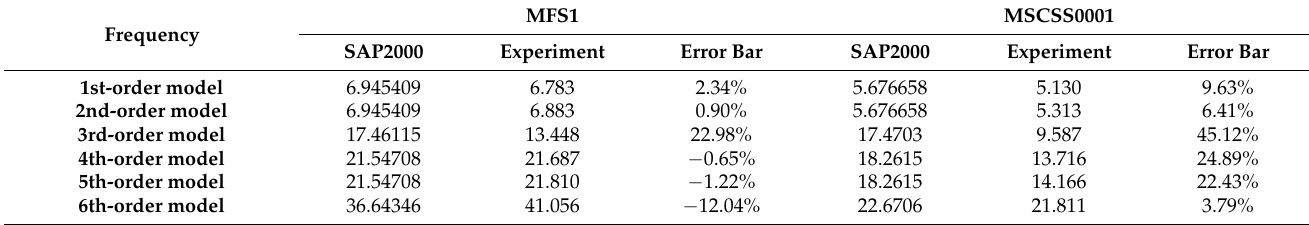
Table 10. The comparations of the theoretical and experimental frequencies (Hz) together with their error